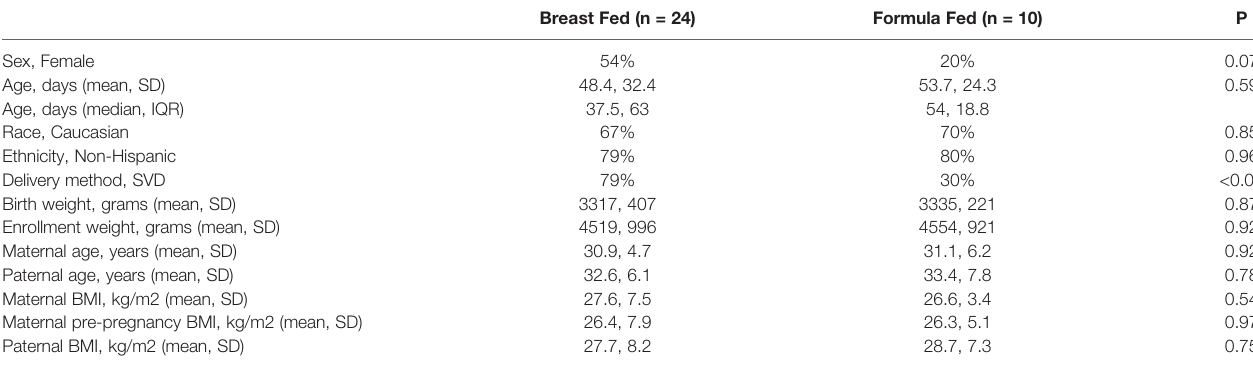
TABLE 1 | Subject Demographic and Anthropometric Data.